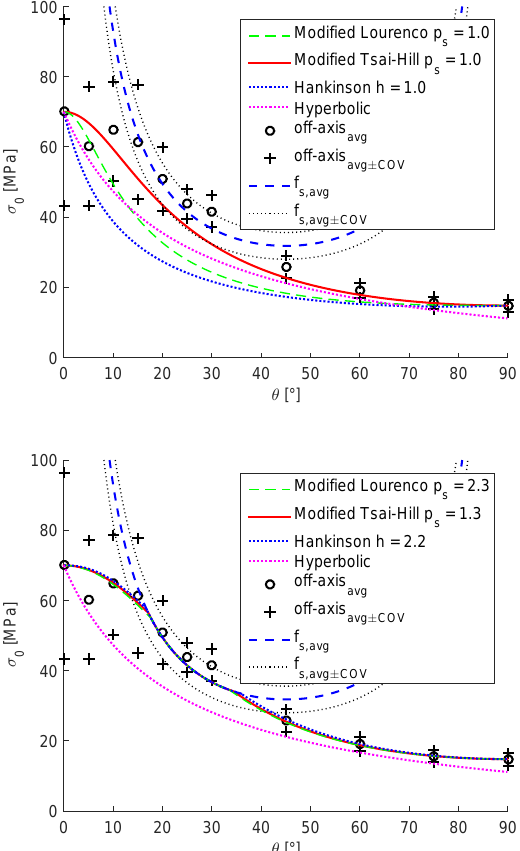
Figure 2. The experimental data of Katsura [7] with uncalibrated (top) and calibrated (bottom) failure